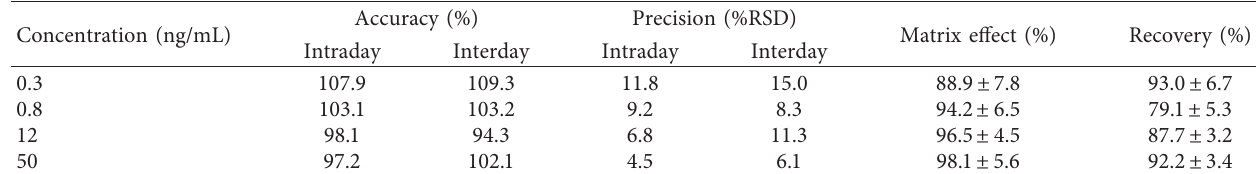
Figure 2: UPLC-MS/MS chromatograms of 10-hydroxy mesaconitine and IS in rat plasma. (a) Blank rat plasma. (b) Blank rat plasma spiked with 10-hydroxy mesaconitine and IS. (c) Rat plasma after oral administration of 10-hydroxy mesaconitine. Table 1: Accuracy, precision, matrix effect, and recovery of 10-hydroxy mesaconitine in rat plasma.